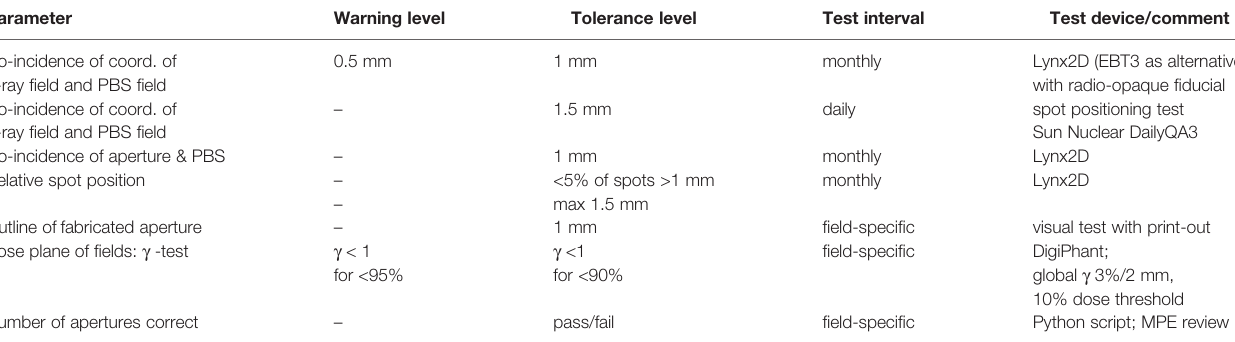
TABLE 3 | Overview of quality assurance procedures. “ MPE review ” refers to the clinical release of a treatment plan by a certi fi ed medical physicist ( “ medical physics expert ” ). Parameter